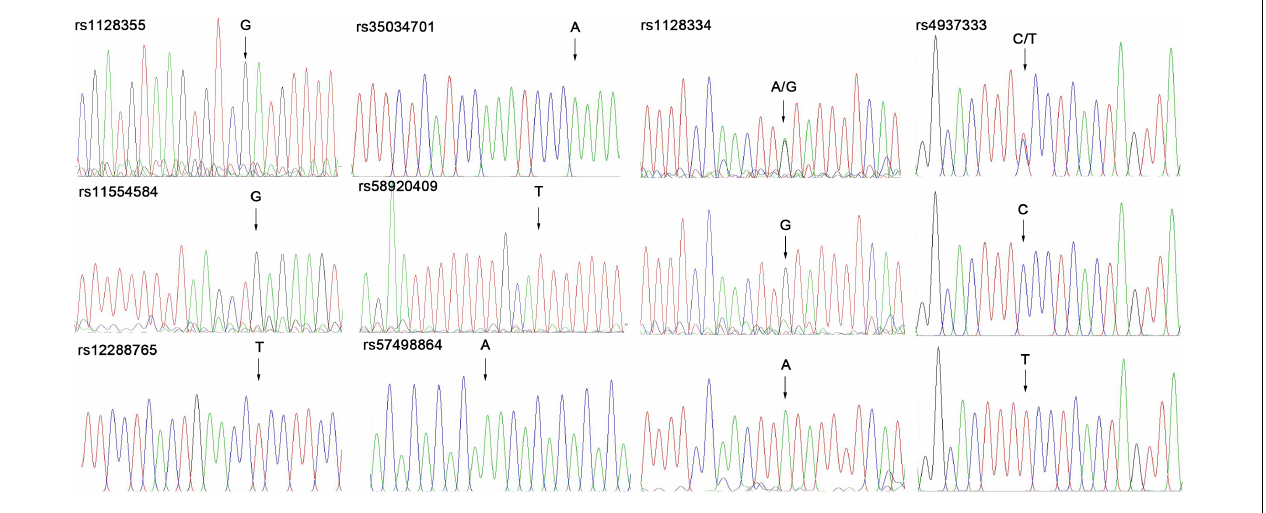
FIGURE 1 | Use of sequencing technology to genotype the SNP in ETS1 .